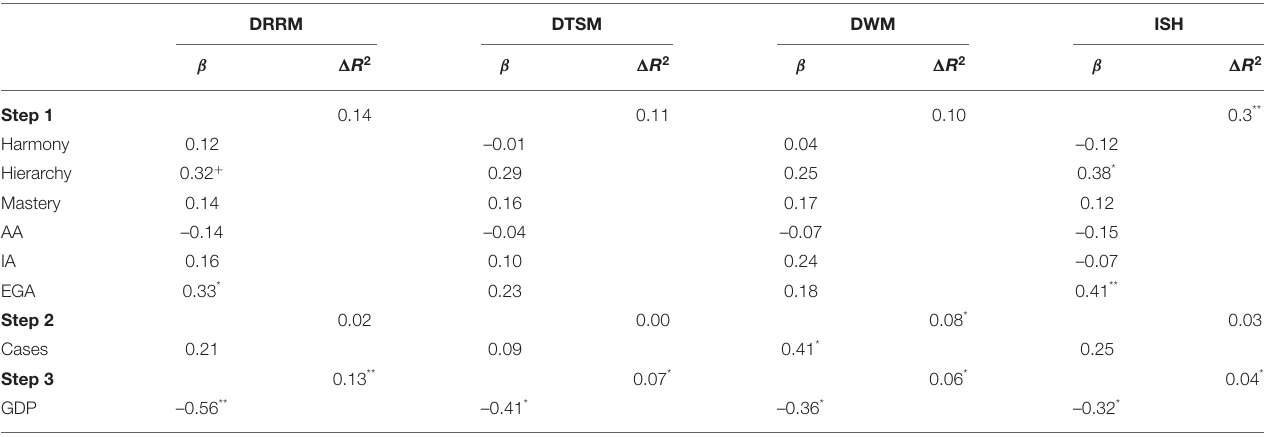
TABLE A1 | Model summary of sequential regression analysis examining relationships between GDP and mobility changes in the Covid-19 pandemic after controlling for cultural value orientations and total